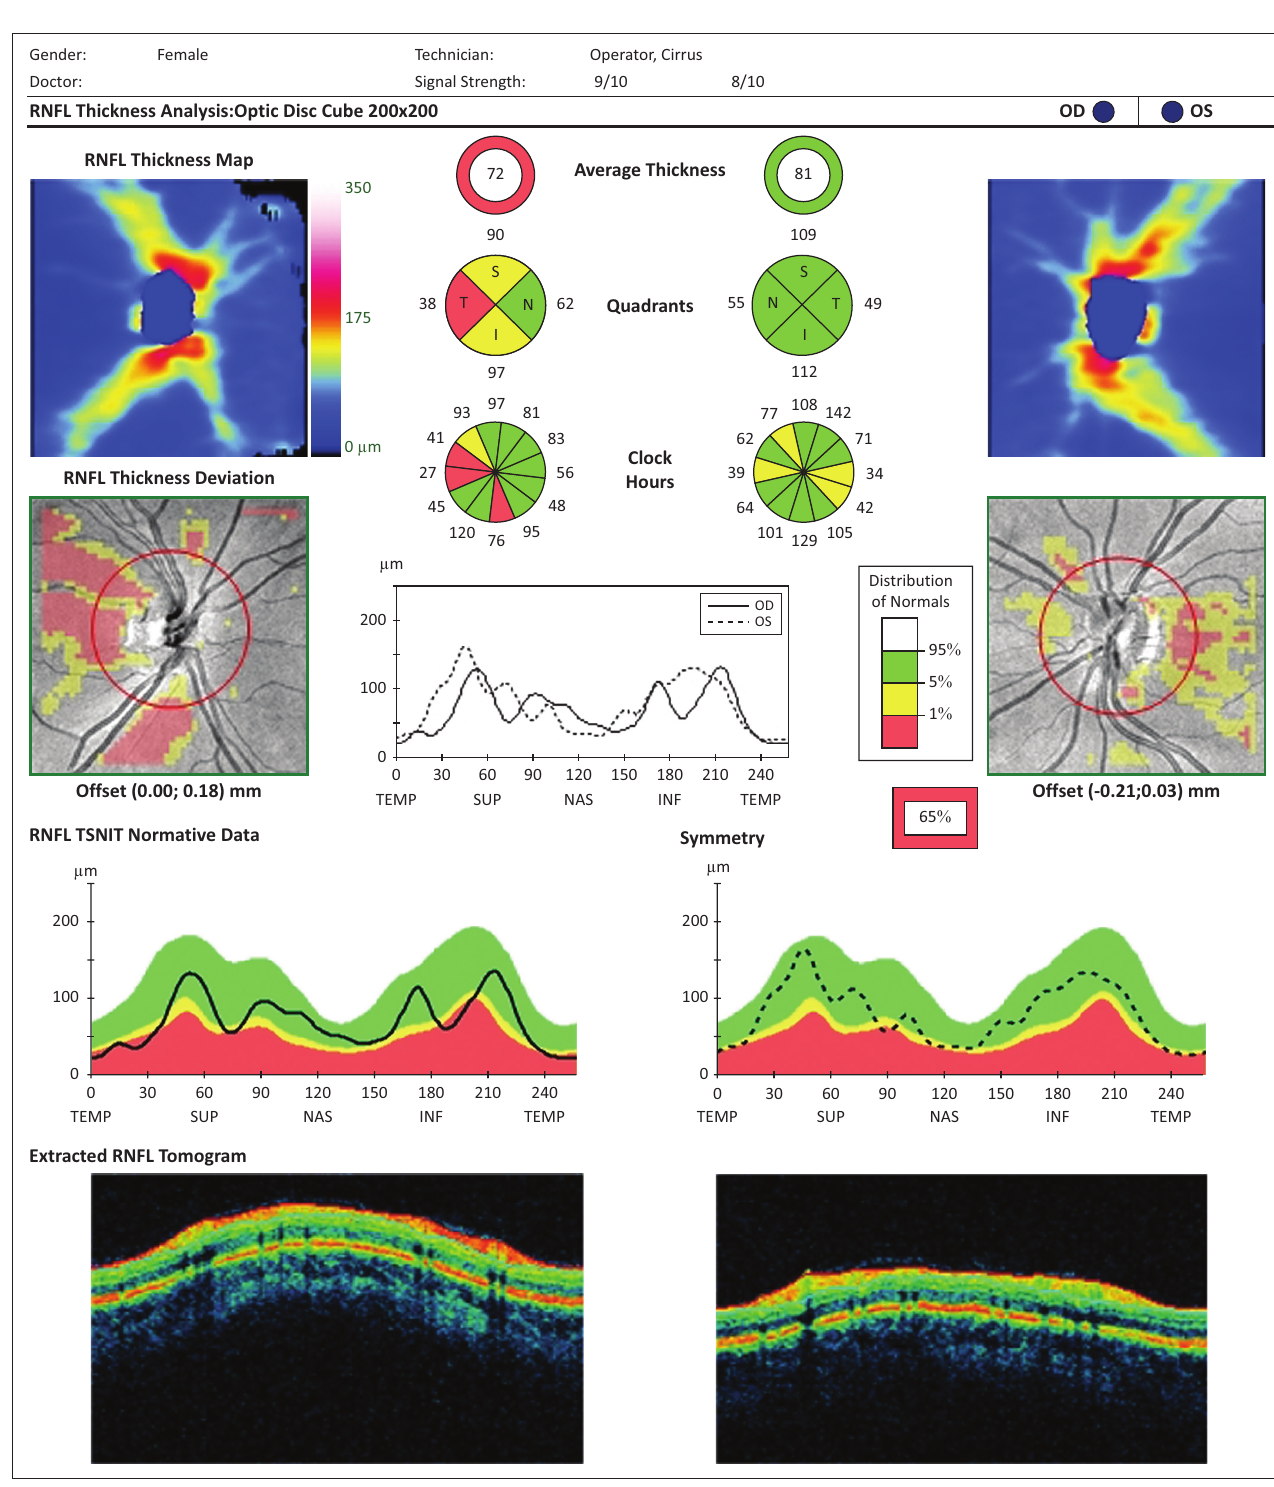
FIGURE 3: Optical coherence tomography findings in a patient with multiple sclerosis and a prior history of right-sided optic neuritis. The average retinal nerve fibre layer thickness in the left eye (OS) is represented in green (indicating a value within normal range), while the average RNFL thickness in the right eye (OD) is represented in red, indicating a reduced RNFL thickness (red denotes values < 1 % of what would be expected when compared with a reference population). The temporal quadrant was the most severely affected, as indicated by the representation in red, followed by the superior and inferior quadrants represented in yellow (yellow denotes values between 1 % and 5 % of what would be expected when compared with a reference